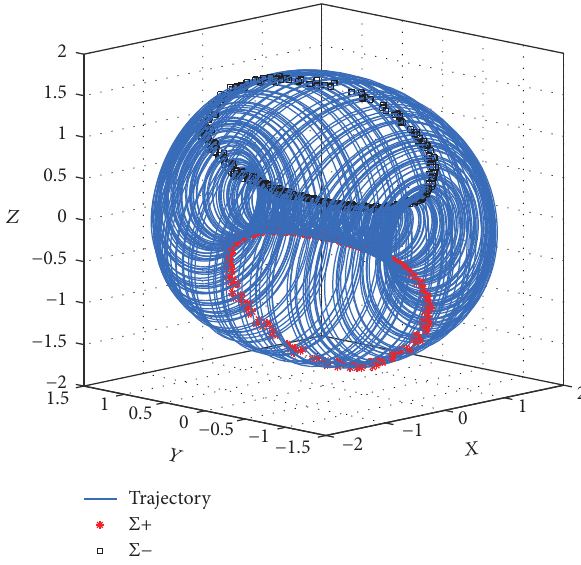
Figure 5: Poincare sections in the 3D state portrait of system (1) ( 𝑋𝑌𝑍